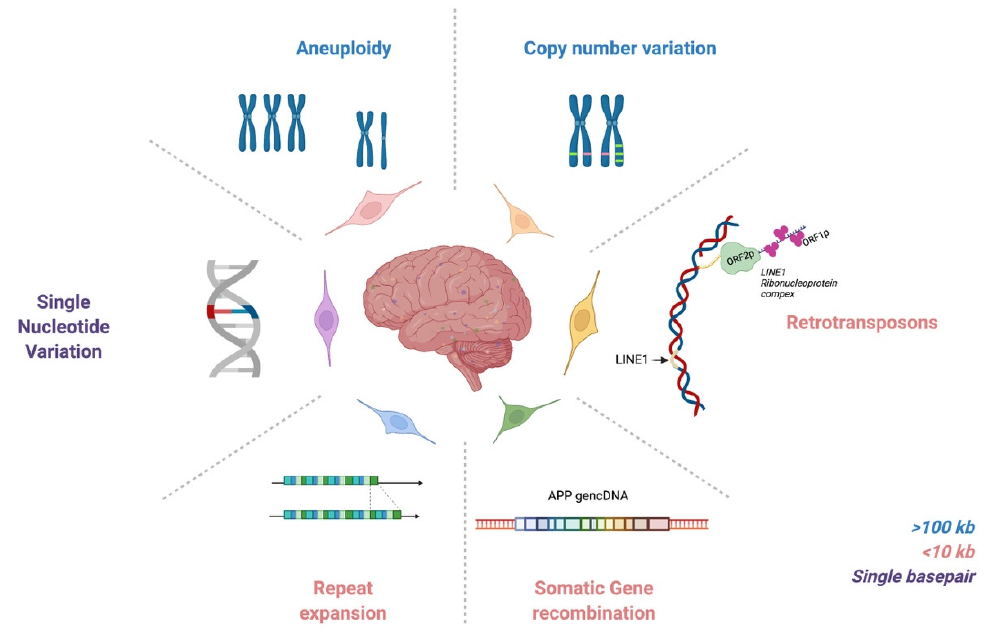
Figure 1. Neural somatic DNA content variation (DCV) encompasses many forms and sizes of somatic changes. Aneuploidies/aneusomies and copy number variations (CNVs) typically reflect large genomic gains/losses that may affect many hundreds of genes. Retrotransposons and somatic gene recombination are reverse transcriptase-mediated insertions of nucleic acids into the genome. Repeat expansions reflect increases in length of instable, small repeating sequences. Single nucleotide variations (SNVs) are the smallest, but most frequent, DNA changes. They encompass changes from one base to another or insertions/deletions of a single base. Together, these somatic changes create genomic mosaicism throughout the human brain.